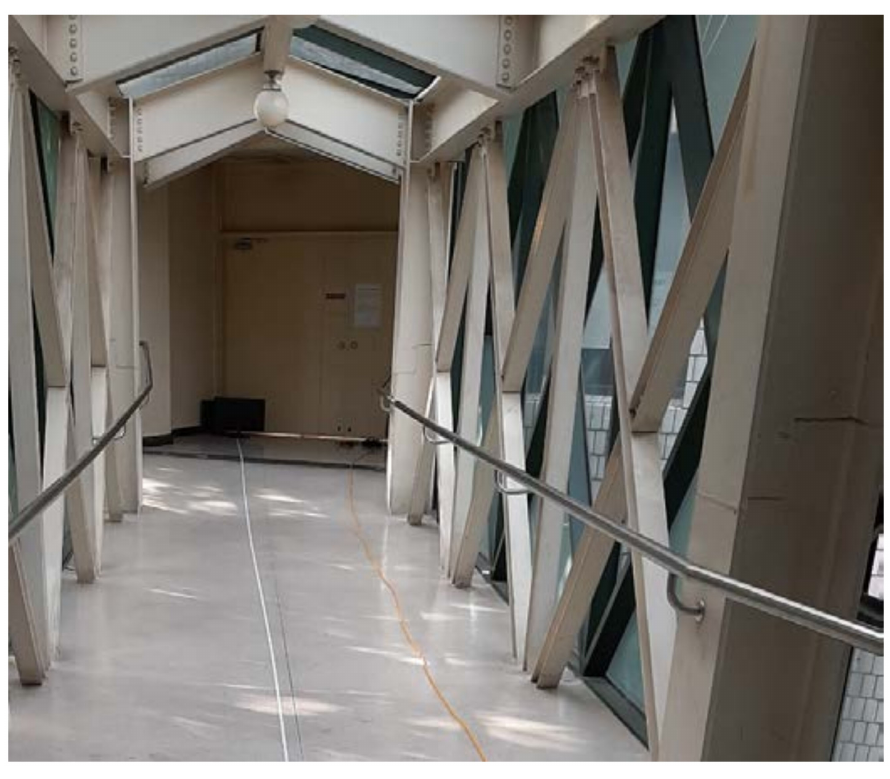
Figure 7. Environment measuring IR reception distance.